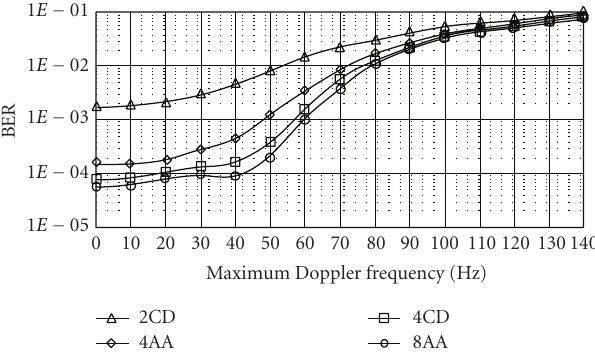
Figure 12: BER versus Maximum Doppler shift with SNR = 30dB.